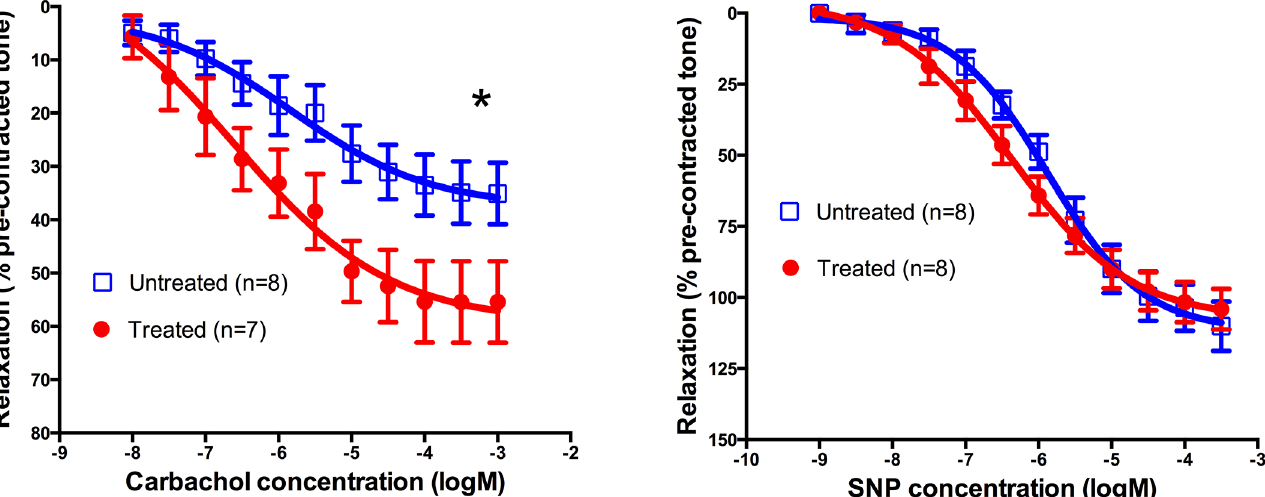
Fig 4. Comparison of vasorelaxation in ovine digital arteries in arthritic sheep treated and untreated with mesenchymal precursor cells (MPC). Arterial rings were contracted with 5-hydroxytryptamine (5-HT), and relaxation responses to cumulatively increasing concentrations of (A) Carbachol and (B) Sodium Nitroprusside (SNP) were expressed as a percentage relaxation of pre-contracted tone. Each point represents the mean ± SEM from 7 – 8 animals. * Indicates statistically significant difference (p < 0.05) in the maximum response for the dilation to carbachol between treated and untreated animals (See Table